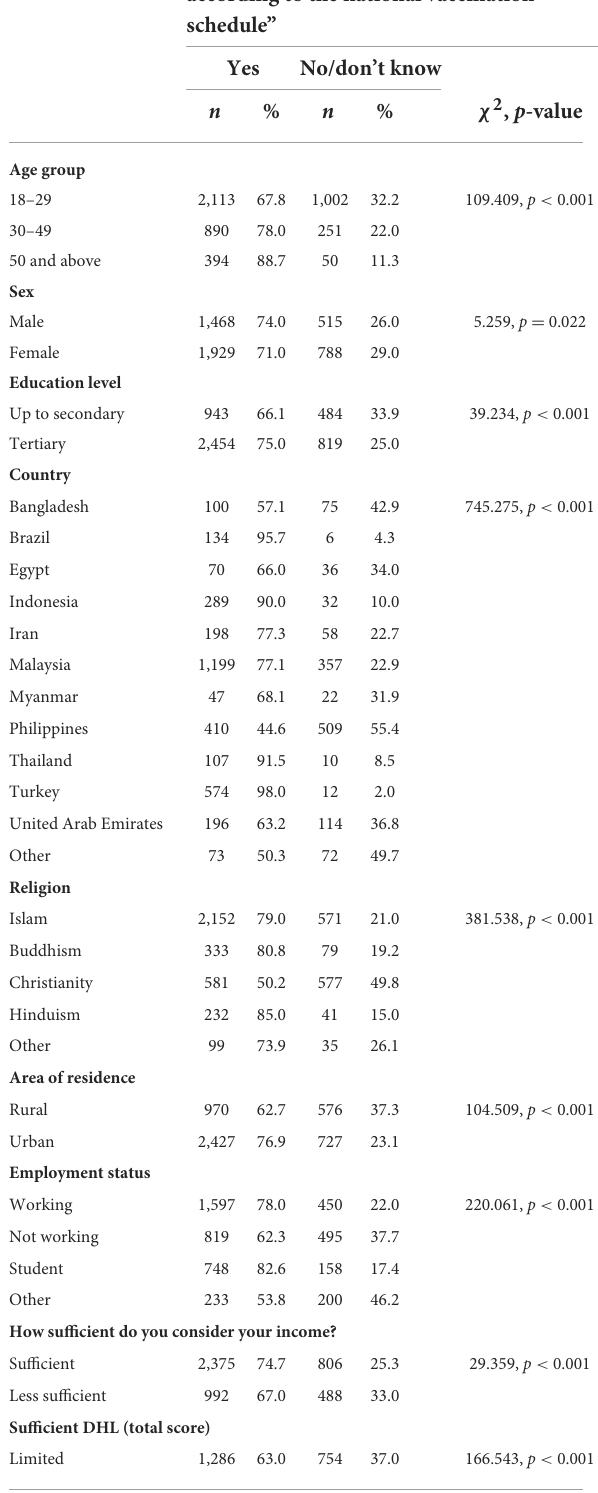
“I think everyone should be vaccinated according to the national